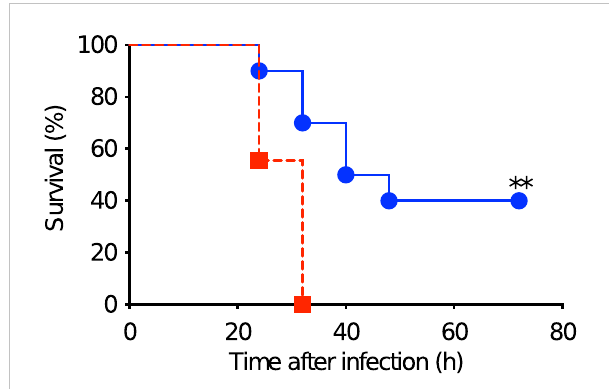
FIGURE 6 Survival after pneumococcal systemic infection in matured offspring. After two weeks of the subcutaneous stimulation with rPspA (at 6 weeks old), the offspring were intraperitoneally infected with S. pneumoniae and monitored every 8 hours until they appeared severely sick. Blue circle with solid line represents offspring derived from and fostered by immunized mother (Group A) (n=10). Red square with dashed line represents offspring derived from and fostered by non-immunized mother (Group D) (n=9). Log rank test was performed for comparison between the two groups. **; P